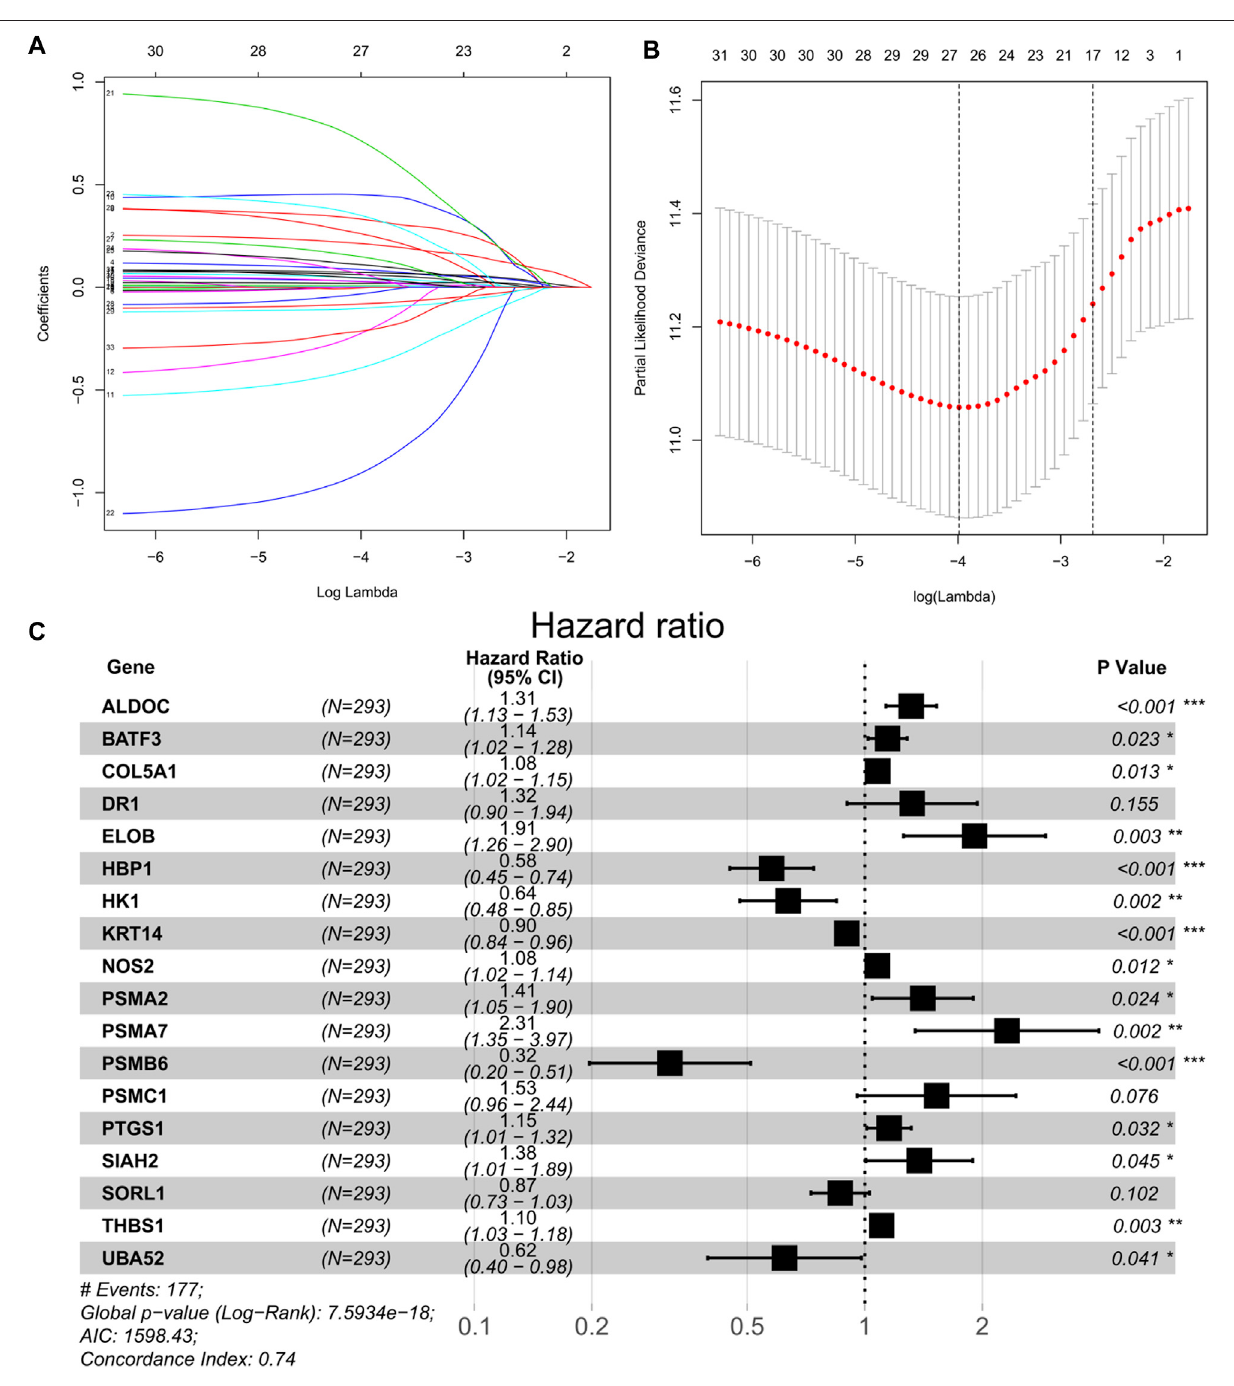
FIGURE 2 | (A) Tenfold cross-validation for tuning parameter selection in the LASSO model. (B) Least absolute shrinkage and selection operator (LASSO) coef fi cient pro fi les of the 33 prognostic genes. (C) Forest plot of 18 hypoxia-related genes signi fi cantly associated with overall survival according to multivariate Cox regression